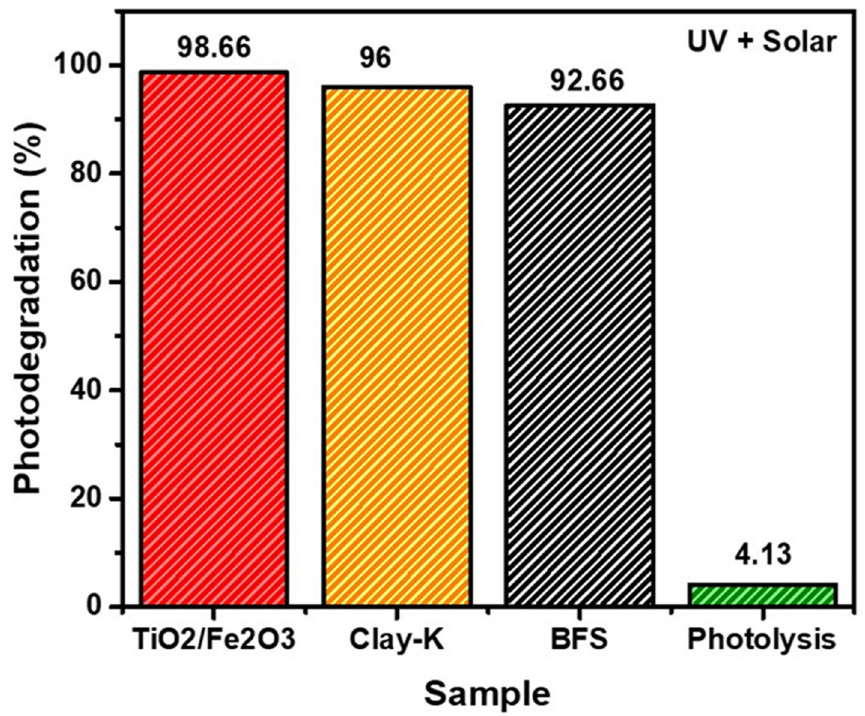
Figure 12. Percentages of cyanide photodegradation with Clay-K, BFS, and Fe 2 O 3 /TiO 2 materials using UV and solar irradiation for 2 h. Initial concentration of NaCN of 750 mg/L.